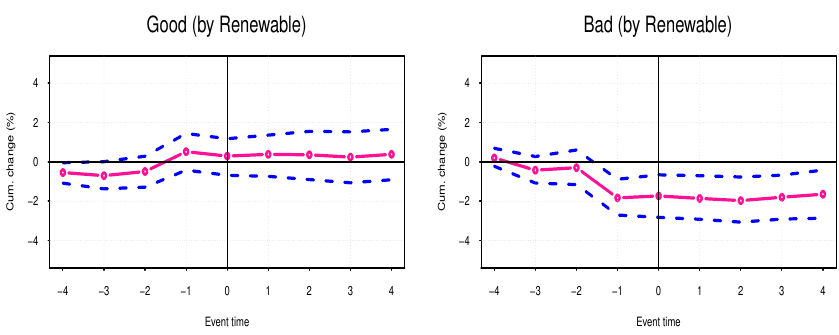
Figure 12. Extreme event on Renewable and response of Brent oil.